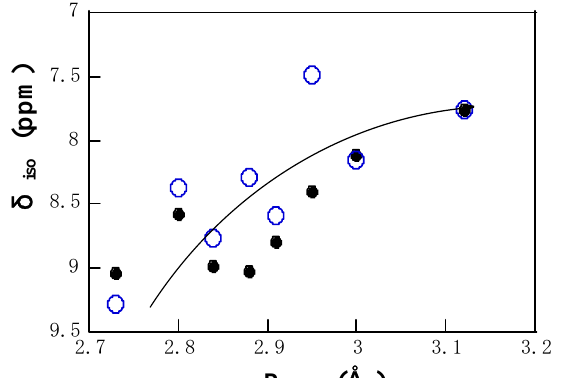
of the amide iso